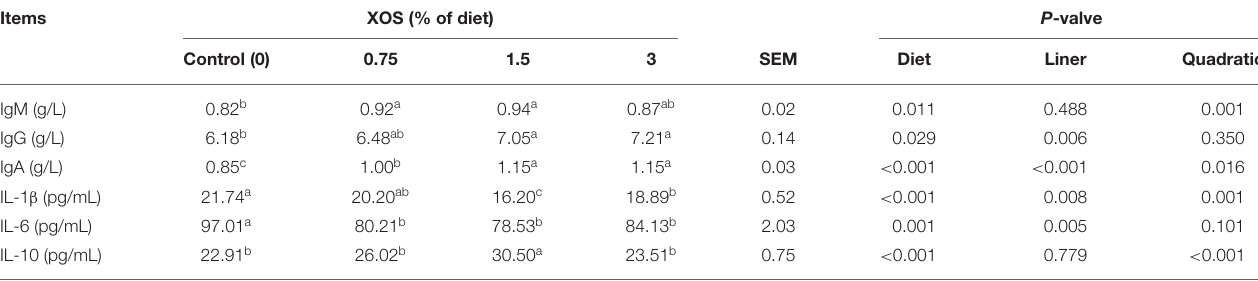
TABLE 6 | The effects of XOS supplementation on immunological function and inflammatory cytokines of weaning piglets. Items